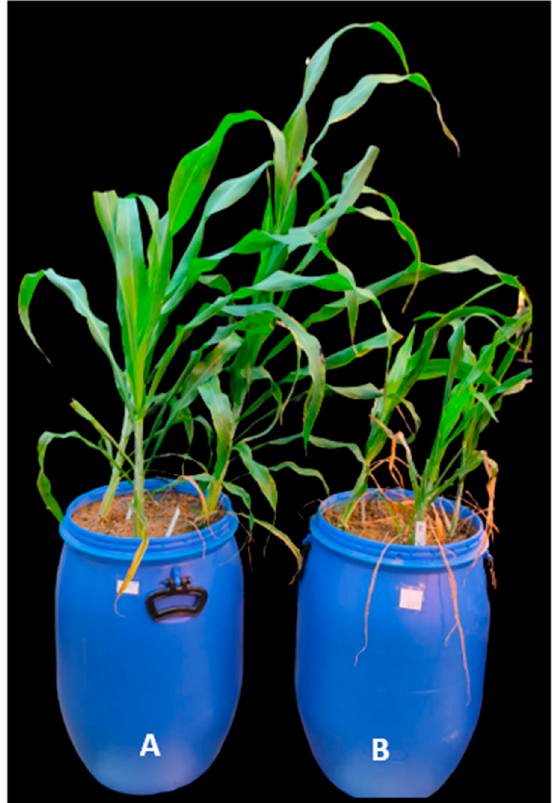
Figure 5. Picture showing plants in well-watered ( A ) vs. early drought stress ( B ) conditions 38 days after drought stress induction.